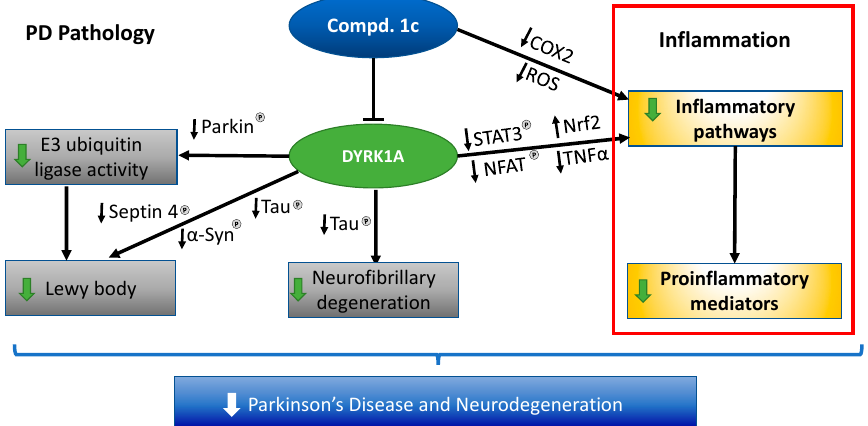
Figure 4. Proposed mechanism of action of DYRK1A and compound 1c in Parkinson’s disease. DYRK1A is a proline-directed serine/threonine kinase for which many proteins have been shown as substrates [11]. DYRK1A activity may be involved in PD and